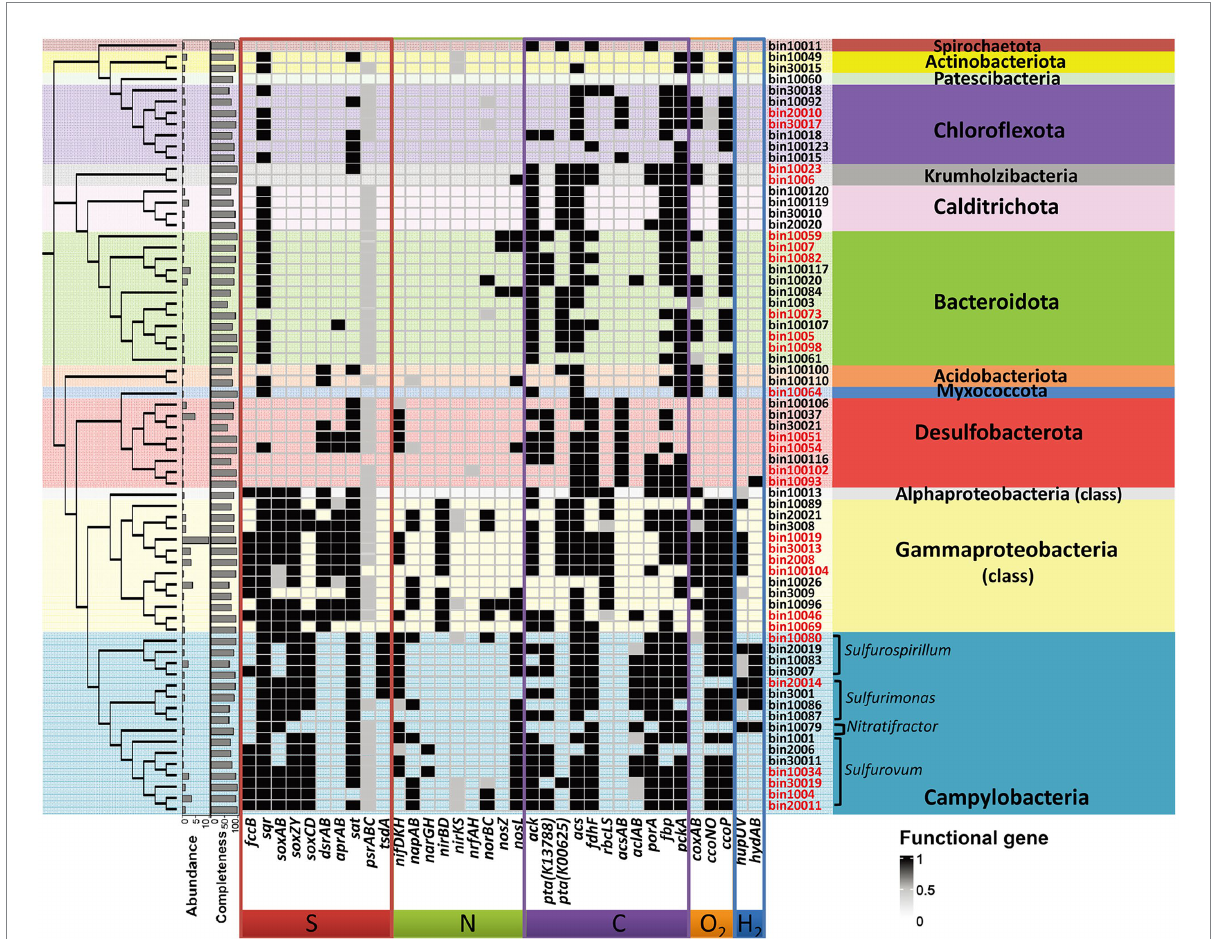
FIGURE 5 Differences in genomic information and key genes involved in carbon, hydrogen, nitrogen, sulfur and oxygen metabolism among 69 MAGs. The name of MAGs colored with red indicate the high quality MAGs with completeness >90%. The dendrogram showing the clusting of MAGs was generated from GTDB-tk. The phylum name was shown for all the MAGs. The identification of genus for the dominant Campylobacteria was inferred from the genomic phylogenetic tree (Supplementary Figure